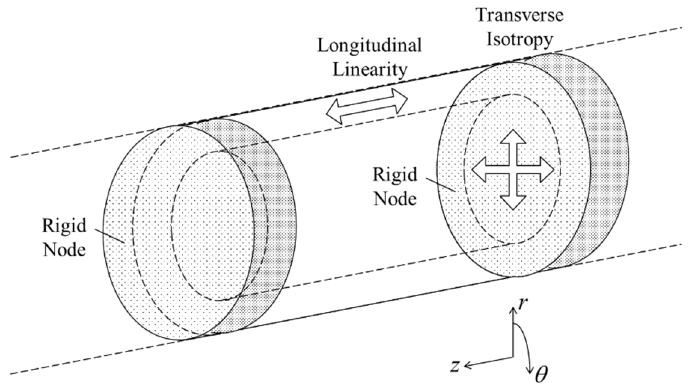
Figure 2. Schematic representation of internodal unit of bamboo.